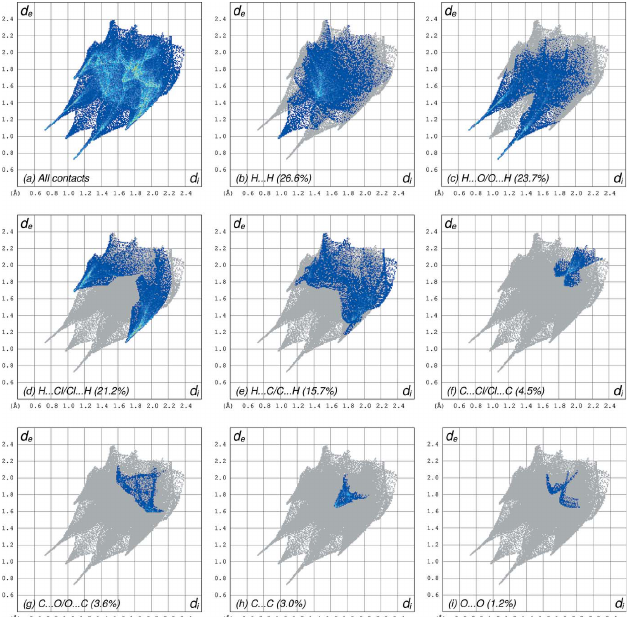
Figure 3 Hirshfeld surface fingerprint plots showing the relative contributions of various atom–atom contacts in the packing of I . ( a ) All contacts, ( b ) H (cid:2)(cid:2)(cid:2) H (26.6%), ( c ) H (cid:2)(cid:2)(cid:2) O/O (cid:2)(cid:2)(cid:2) H (23.7%), ( d ) H (cid:2)(cid:2)(cid:2) Cl/Cl (cid:2)(cid:2)(cid:2) H (21.2%), ( e ) H (cid:2)(cid:2)(cid:2) C/C (cid:2)(cid:2)(cid:2) H (15.7%), ( f ) C (cid:2)(cid:2)(cid:2) Cl/Cl (cid:2)(cid:2)(cid:2) C (4.5%), ( g ) C (cid:2)(cid:2)(cid:2) O/O (cid:2)(cid:2)(cid:2) C (3.6%), ( h ) C (cid:2)(cid:2)(cid:2) C (3.0%), (i) O (cid:2)(cid:2)(cid:2) O (1.2%). All other contact types are <1%.